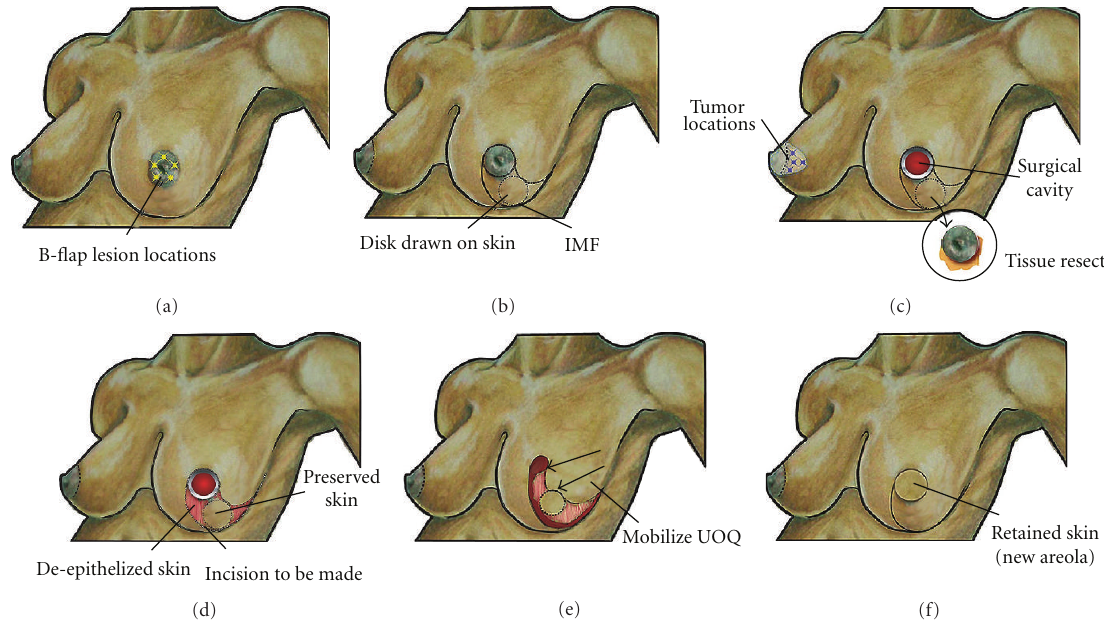
Figure 8: B-flap resection. (a) Shows multiple stars with possible tumor locations. (b) Shows location of skin incision, including disk of skin to be preserved. (c) Shows surgical cavity after excision of central lumpectomy with removal of nipple-areolar complex (inset). For illustration purposes, medial profile view of right breast shows multiple “stars” indicating possible tumor locations suitable for this approach. (d) Shows surgical cavity, areas of de-epithelized skin, preserved disk of epithelized skin, and location of incision to be made in the glandular tissue. (e) Shows advancement and clockwise rotation of lower outer quadrant until disk of skin occupies the nipple-areolar complex position. (f) Shows breast following approximation and closure of the skin incisions. De-epithelized skin is buried below the skin of the lower inner quadrant and the disk of skin forms a new areola.